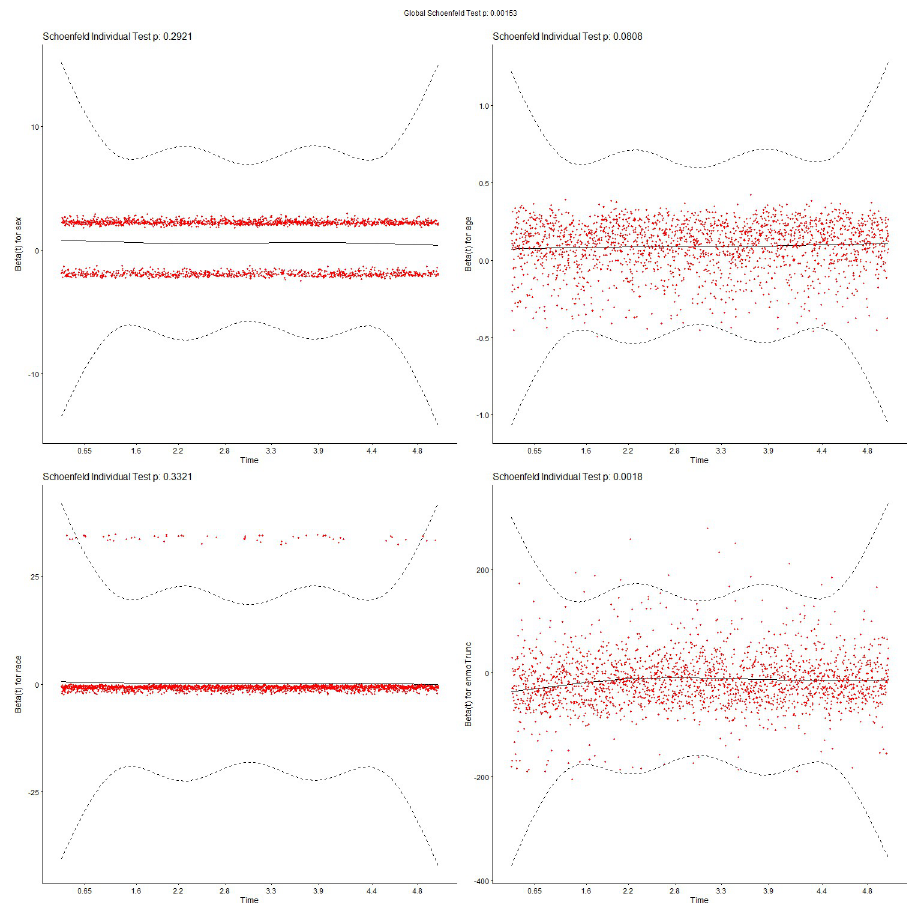
Fig 8. Feature tests for proportionality of risks: Demographics +